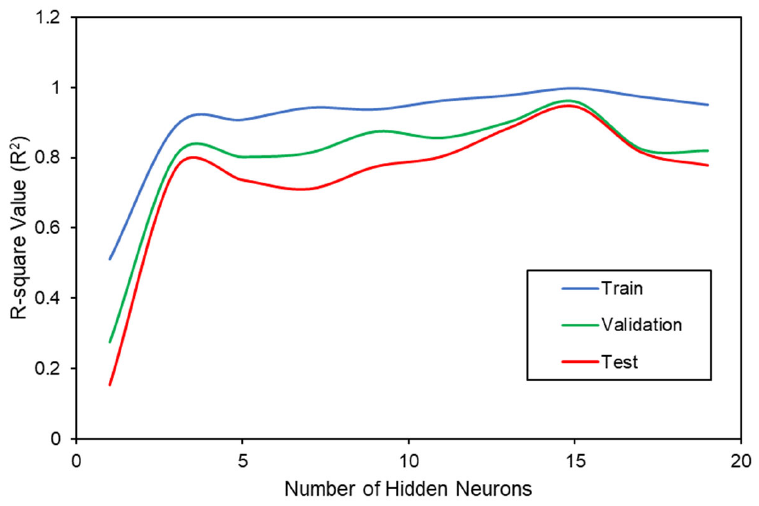
Figure 3. The variation in R-square values in relation to the number of neurons in the created ANN.